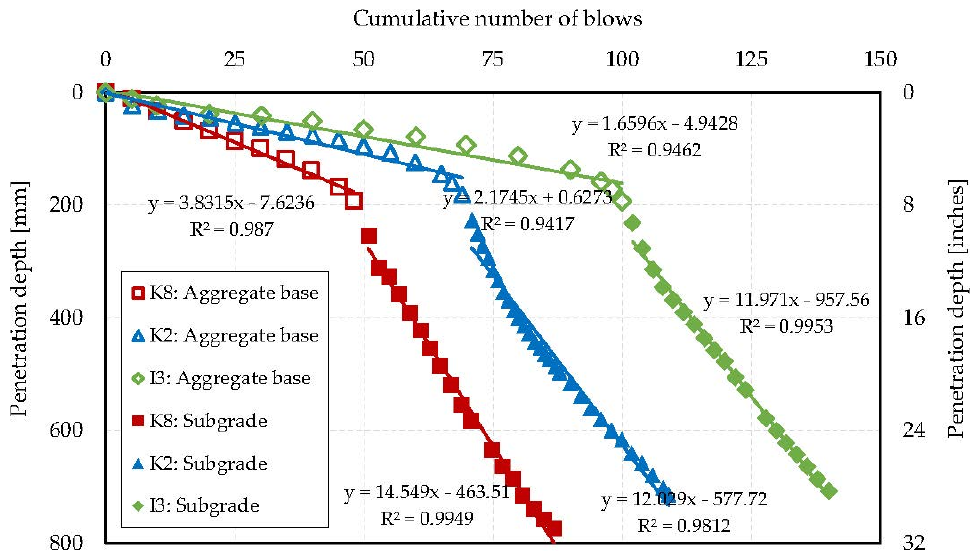
Figure 2. The results of the dynamic cone penetrometer (DCP) tests for the aggregate base and subgrade layers. Table 2. Back-calculated properties of support layers by DCP results. (1 psi = 6.89 kPa). DCP index (DCPI), DCP